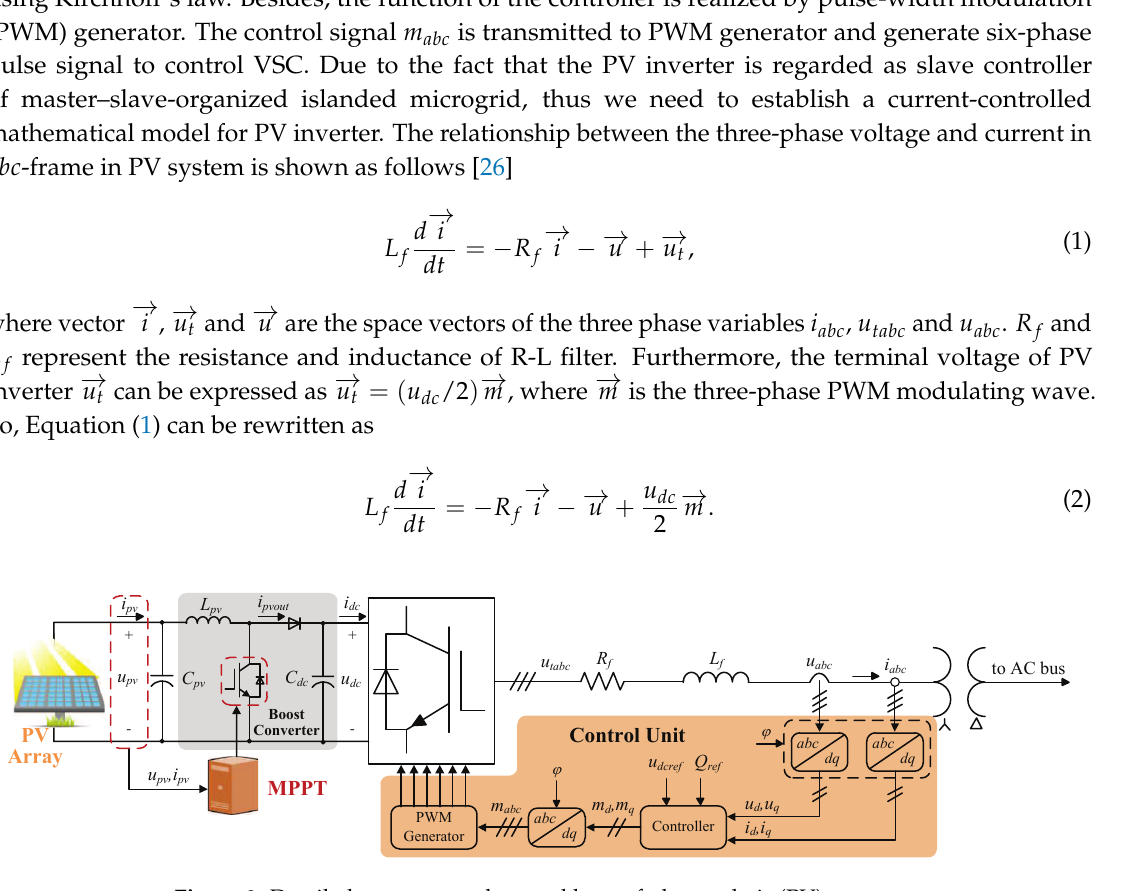
Figure 2. Detailed structure and control loop of photovoltaic (PV)